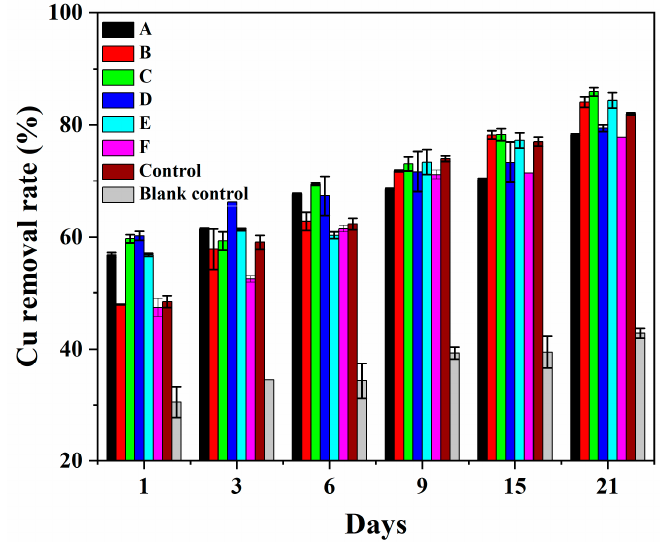
Figure 9. Cu removal rate from CCA-treated wood using domesticated strains compared with untreated ones; samples (A) and (B) were stressed for 4 and 8 days, respectively, with Cu 2+ concen- trations of 600 mg · L − 1 ; samples (C) and (D) were stressed for 12 and 14 days, respectively, with Cu 2+ concentrations of 700 mg · L − 1 ; samples (E) and (F) were stressed for 12 days with Cu 2+ concentrations of 800 and 1000 mg · L − 1 , respectively; the control was strains with OD 600nm = 0.6 without the addition of Cu 2+ ; the blank control was the growth medium without any strains.